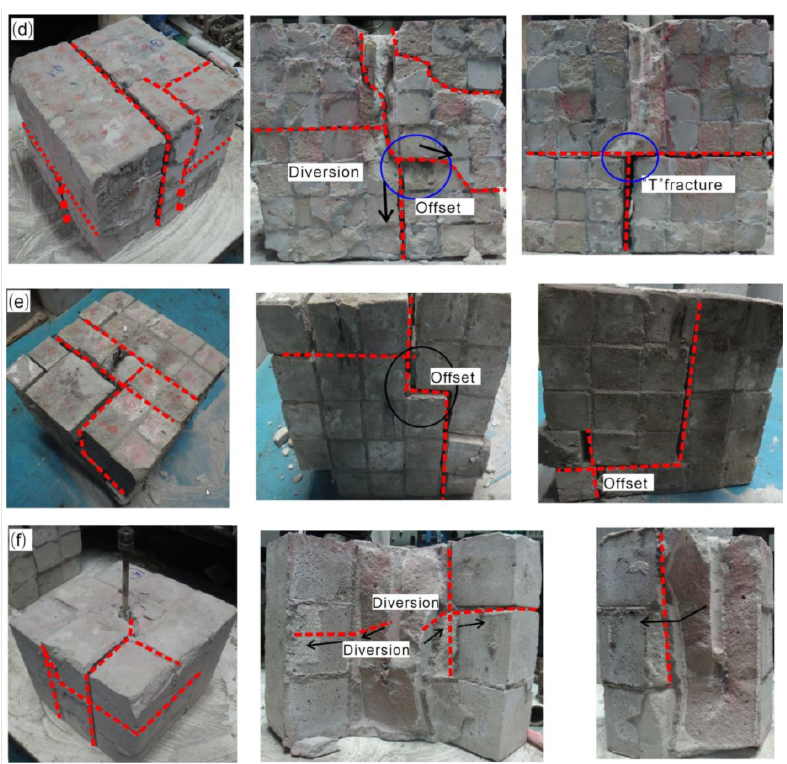
Figure 11. Sketch of the failure morphology fracturing planes with different NFD. ( a – c ) Model blocks with dense, medium, and sparse DFN connectivity, and the mix ratio of the cement paste interface is 1:0. ( d – f ) Model blocks with dense, medium and sparse DFN connectivity, and the mix ratio of cement paste interface is